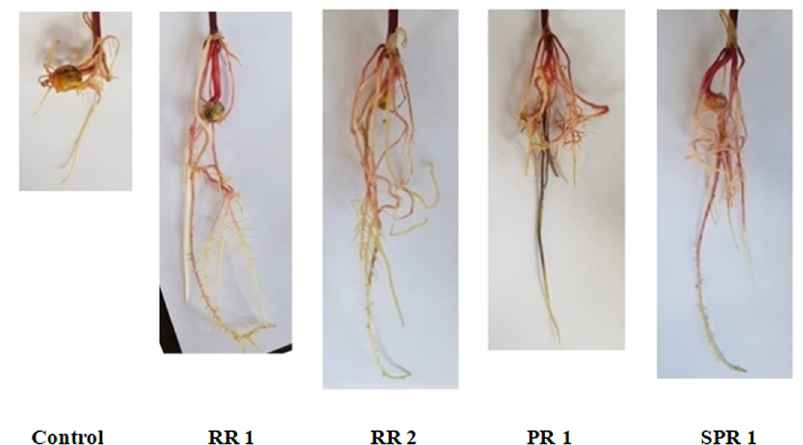
Figure 2: The performance and the root length of PSB - inoculated maize seedling.